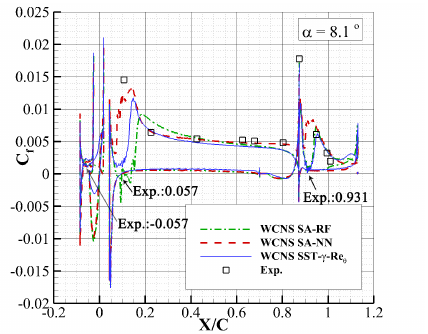
Figure 19. Fractional drag coefficient of 30P30N airfoil.